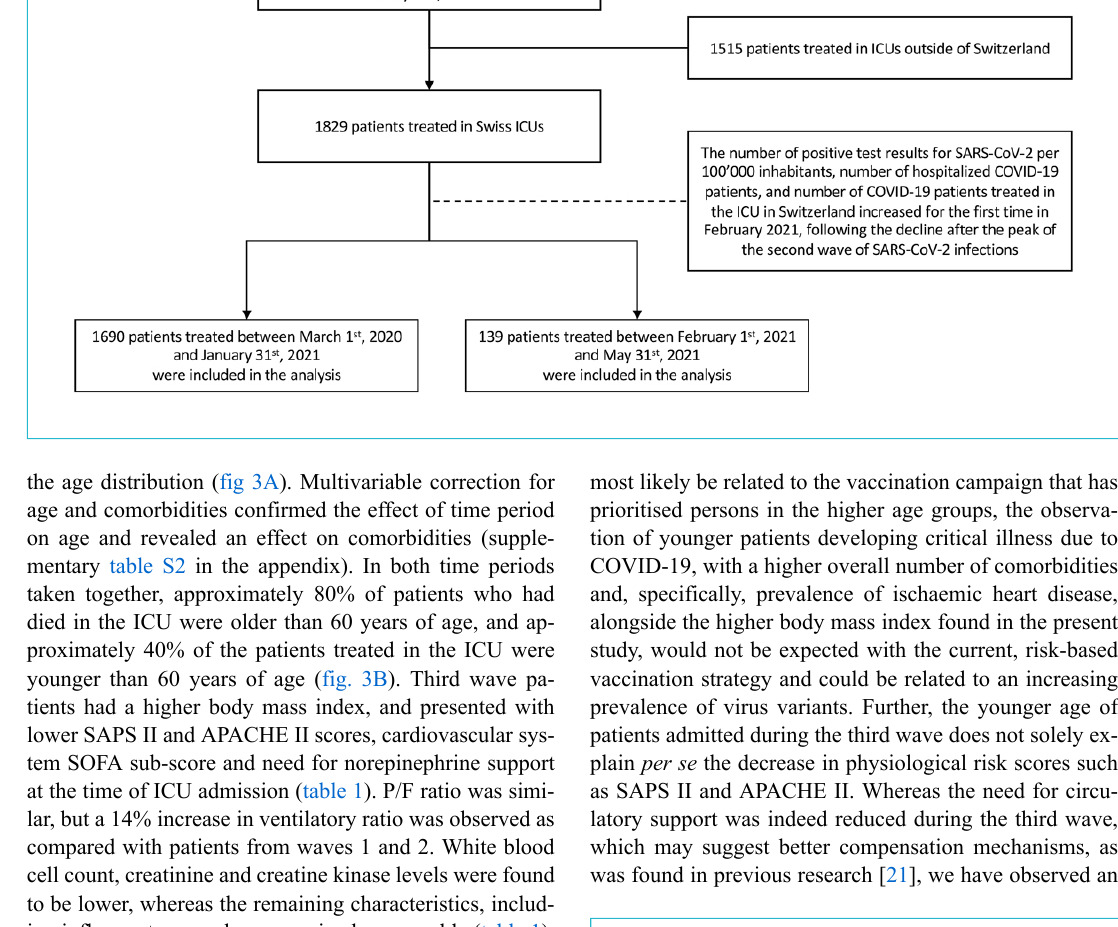
Figure 3: The age distribution of patients admitted to the in- tesnsive care unit (ICU) (A) shifted towards younger patients at the onset of the third wave of SARS-CoV-2 infections in Switzerland in comparison with the previous pandemic course. Overall, the ICU mortality (B) is accounted with approximately 80% to patients older that 60 years of age, whereas approximately 40% of the patients treated in the ICU were younger than 60 years of